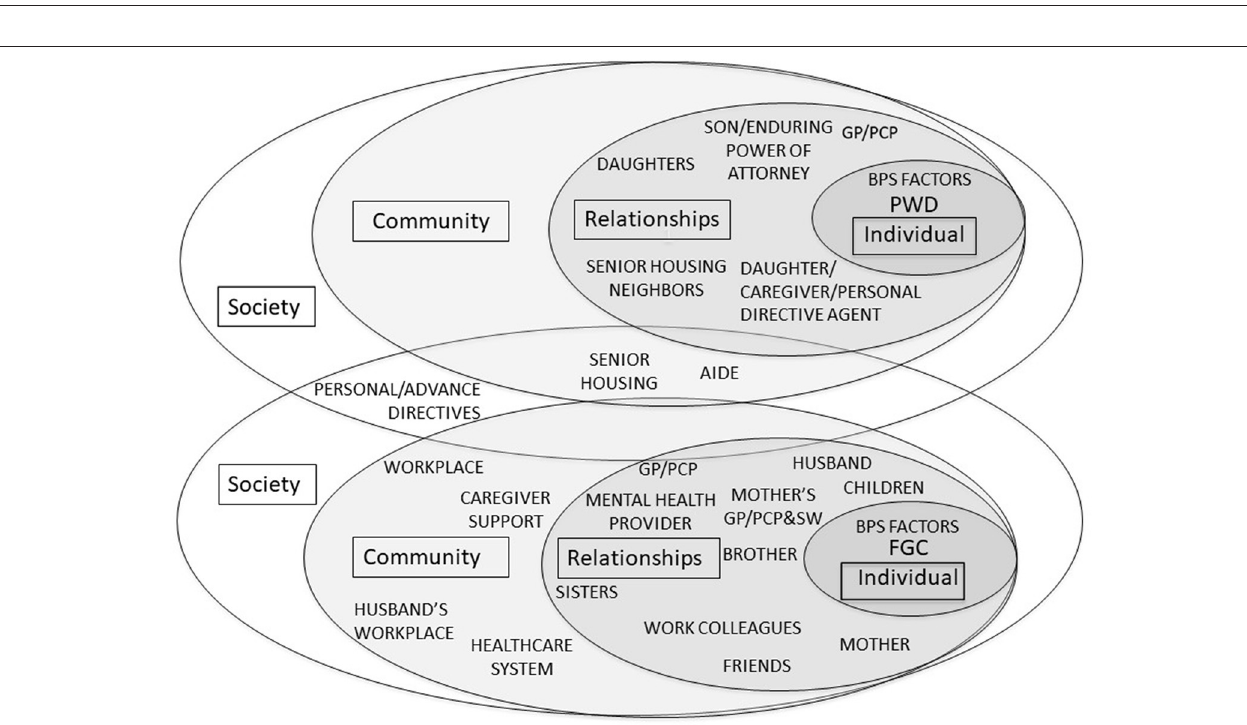
FIGURE 1 | Biopsychosocial-Ecological Approach to Patient-Centered Dementia Care.